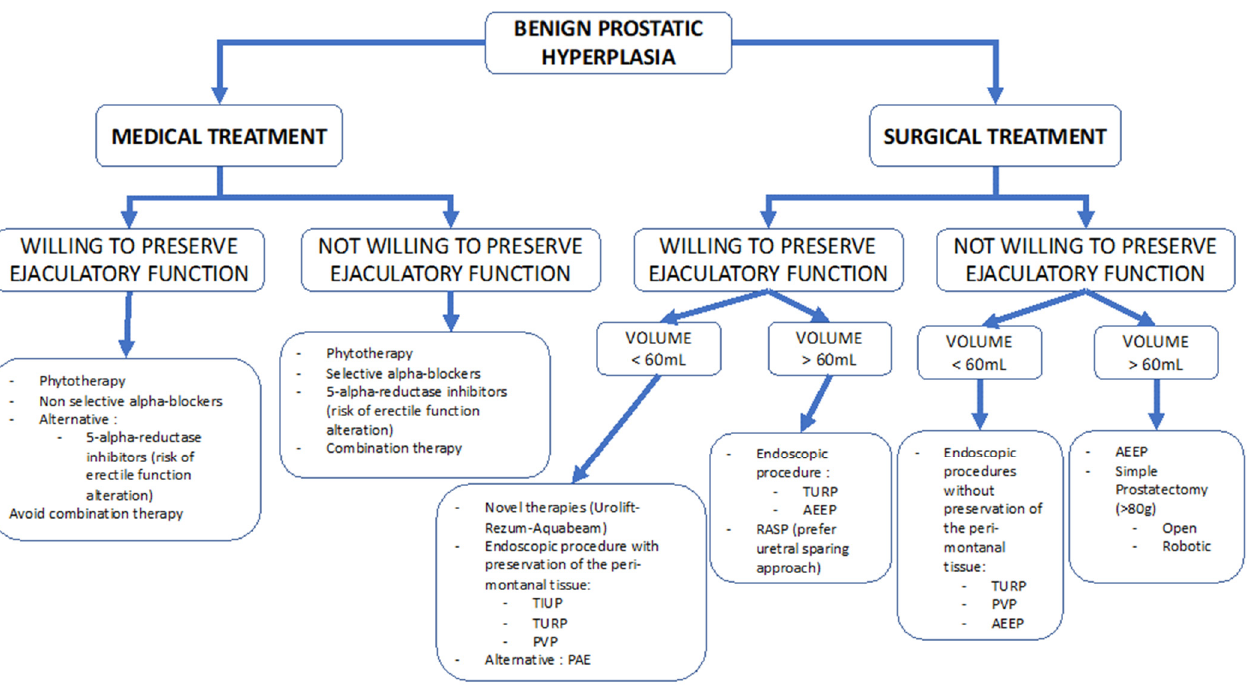
Figure 1. Decision tree according to the ejaculatory function patients’ demand and treatment in case of benign prostatic hyperplasia. TUIP: transurethral incision of prostate; TURP: transurethral resection of prostate; PVP: photovaporization of prostate; PAE: prostate artery embolization; AEEP: anatomical endoscopic enucleation of the prostate; RASP: robot-assisted simple prostatectomy .